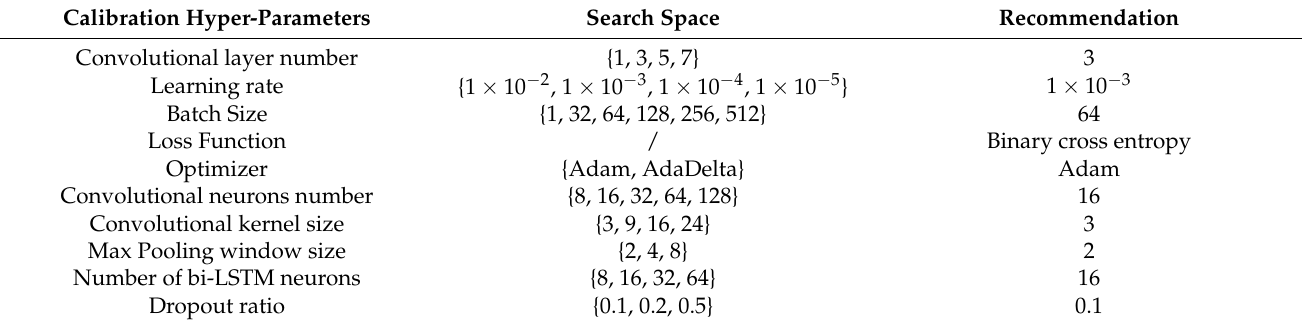
Table 1. DeepD2V Hyper-parameters, search space, and